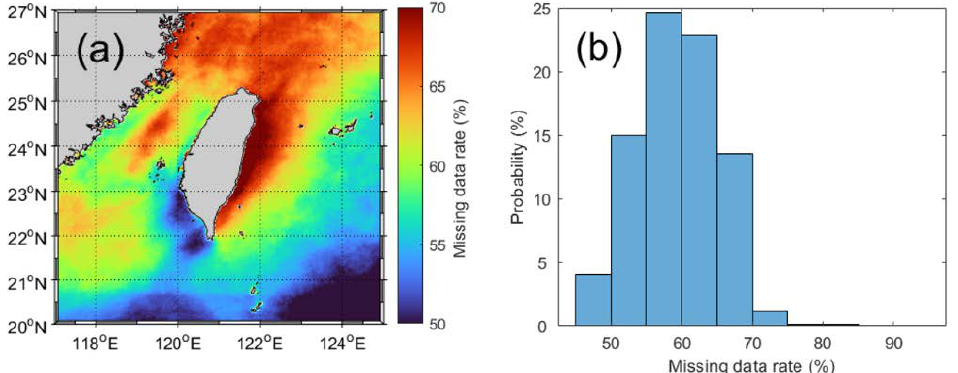
Figure 3. ( a ) Spatial distribution of the missing data rate. ( b ) Histogram of overall missing data rate.